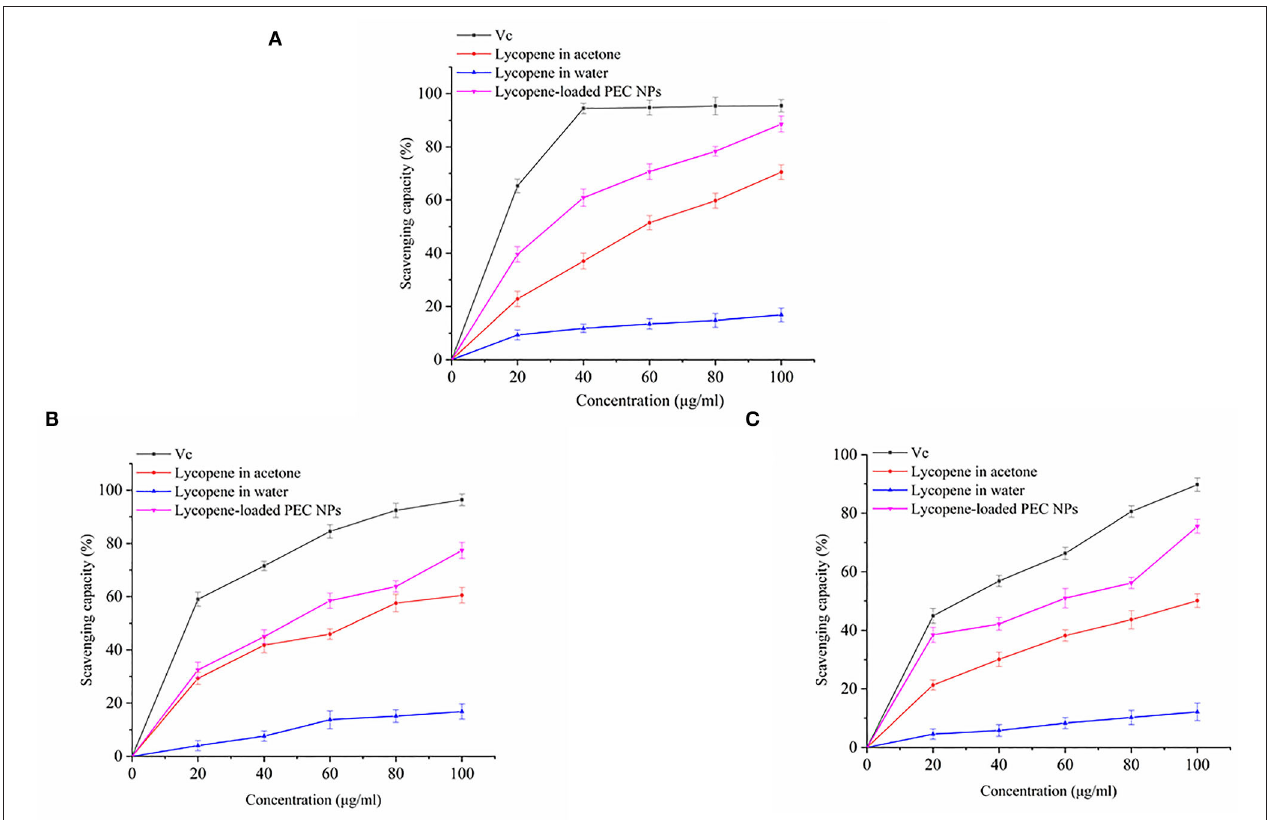
FIGURE 9 | (A) DPPH radical scavenging activity, (B) Hydroxyl radical scavenging activity, and (C) ABTS free radical scavenging activity of Vc, lycopene in acetone, lycopene in water, lycopene-loaded PEC NPs.